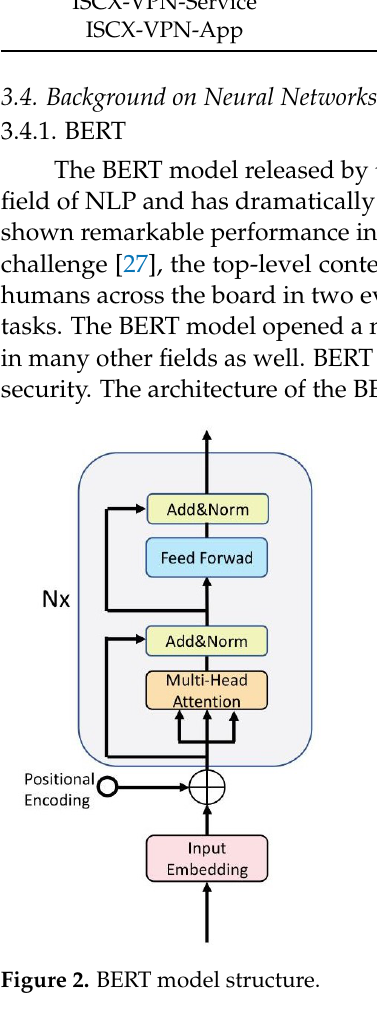
Table 3. The statistical information of the datasets. Dataset